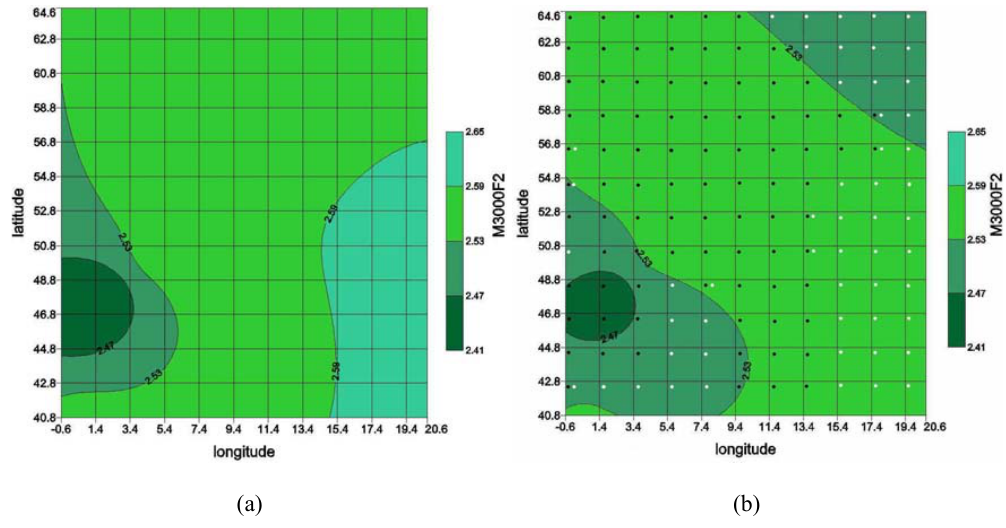
Fig. 5. (a) Map obtained from M3000F2 measurements and (b) long-term prediction map for M3000F2 generated using the 9 forecasting local models simultaneously operative for the month of May (see Table 7a). The epoch under consideration, characterized by moderate geomagnetic activity (ap( τ = 0 . 8 ) = 17 . 9; ap( τ = 0 . 9 ) = 18 . 1), is 18 May 1991 at 01:00UT. The white circles indicate the cells where the predictions of M3000F2 are less satisfactory. The black circles indicate the cells where the predictions of M3000F2 quite faithfully match the M3000F2 measurements. The cells labelled with both the circles indicate that the performance can be considered satisfactory only in part of the